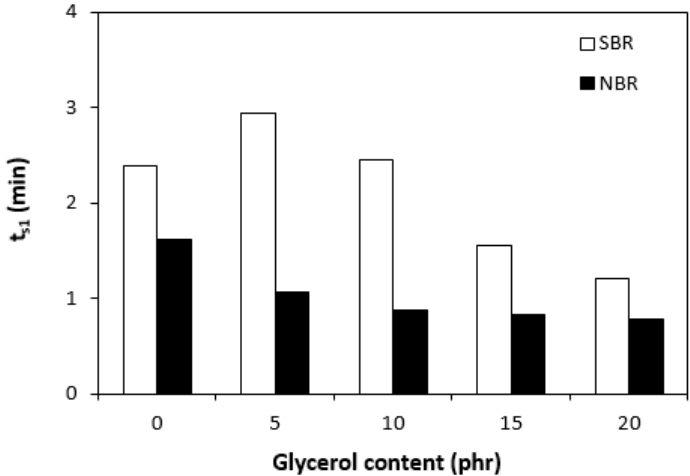
Figure 7. Influence of glycerol content on scorch time (t s1 ) of rubber compounds.